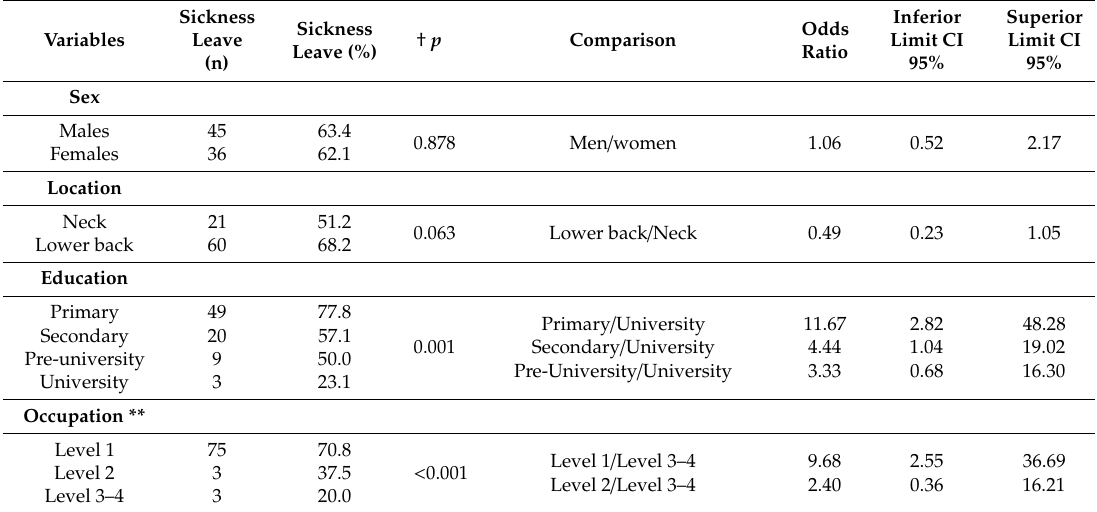
Table 1. Frequency of sickness leave in each sociodemographic group. † Chi-square test *.